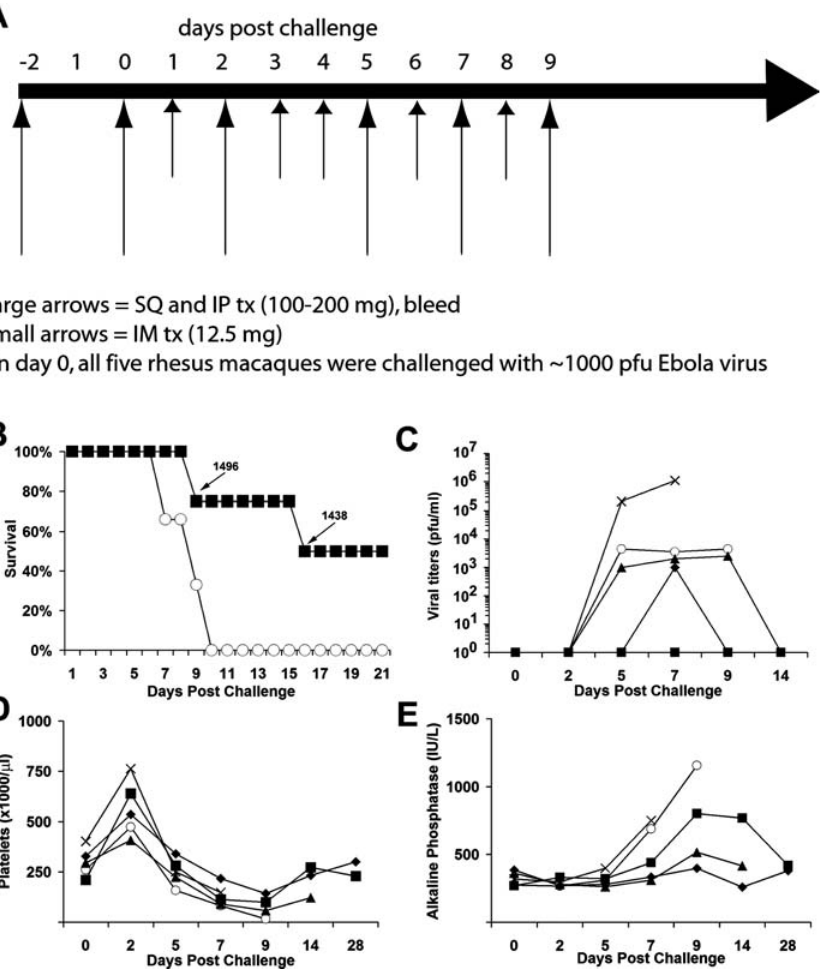
Figure 6. Treatment of Rhesus Macaques with Antisense PMOs Provide Protection against Lethal Ebola Virus Infection (A) Treatment schedule for proof-of-concept trial using PMO to treat lethal Ebola virus infection in nonhuman primates. (B) Survival following infection with 1,000 pfu of EBOV in monkeys treated with a combination of PMOs ( & , n ¼ 4) or untreated monkeys ( * , n ¼ 3). The arrows indicate the time of death of each PMO-treated monkey. (C–E) Viral titers (C), platelet counts (D), or alkaline phosphatase levels (E) in the blood of the PMO-treated monkeys [0646 ( ¤ ), 1438 ( m ), 1496 ( 3 ), 1510 ( & )] or a representative untreated monkey ( * ). DOI: 10.1371/journal.ppat.0020001.g006